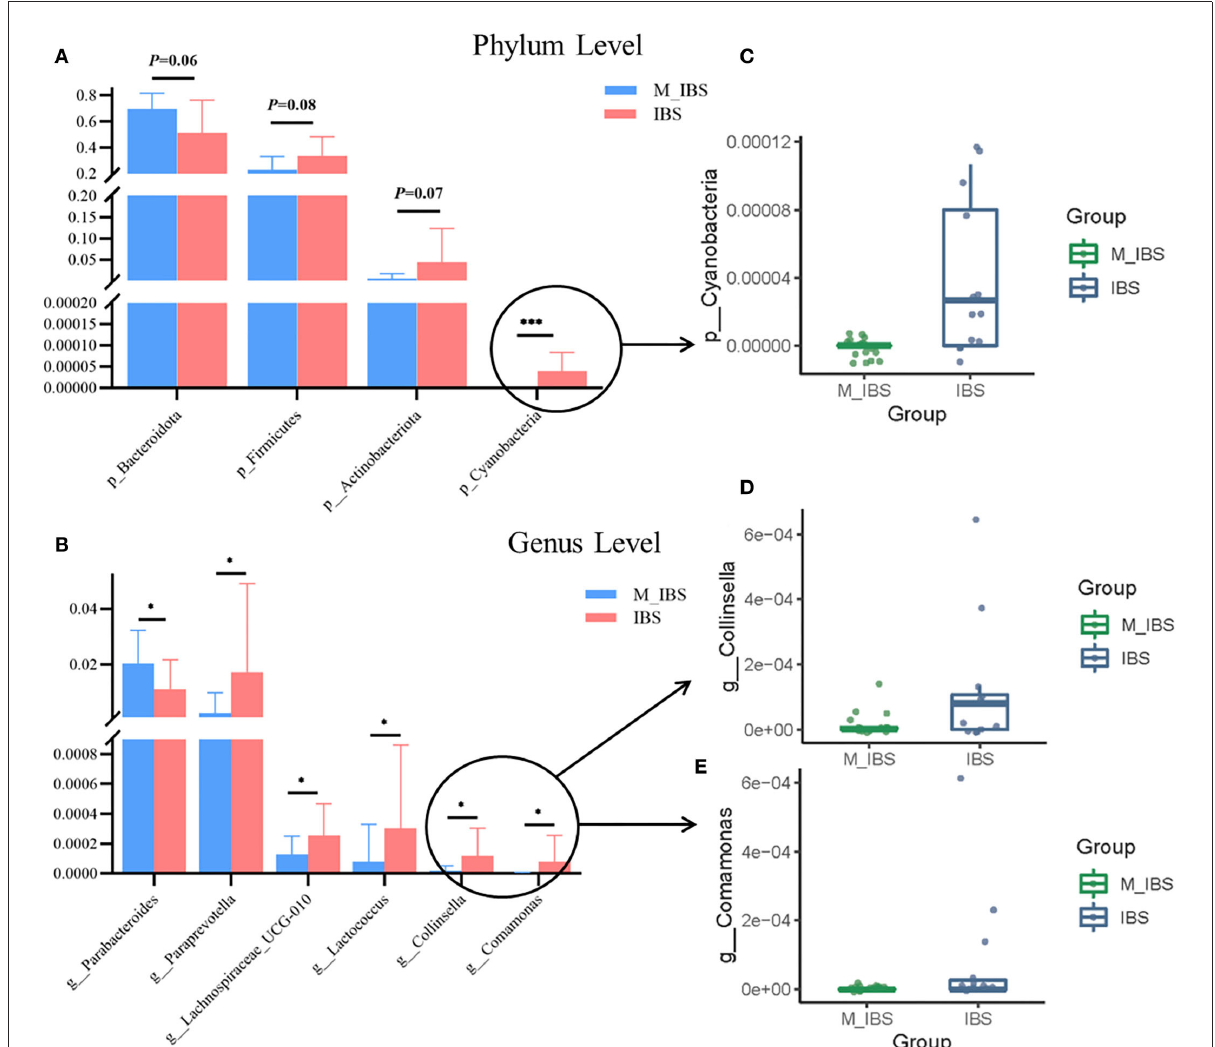
FIGURE3 Relative abundances of gut microbiota in the M_IBS and IBS groups. (A,B) Bar plots comparing abundances of differentially abundant phyla and genera between the M_IBS and IBS groups, and only p < 0.05 or trending results are shown. (C–E) Box plots comparing differential phyla and genera with lower relative abundance values in bar plots between the M_IBS and IBS groups. These “signature” taxa were selected using Wilcoxon rank-sum tests and a false discovery rate of 5%. Error bars represent standard deviations, and phylum-level and genus-level taxa are plotted. * P < 0.05; *** P < 0.001. M_IBS, migraine with irritable bowel syndrome; IBS, irritable bowel